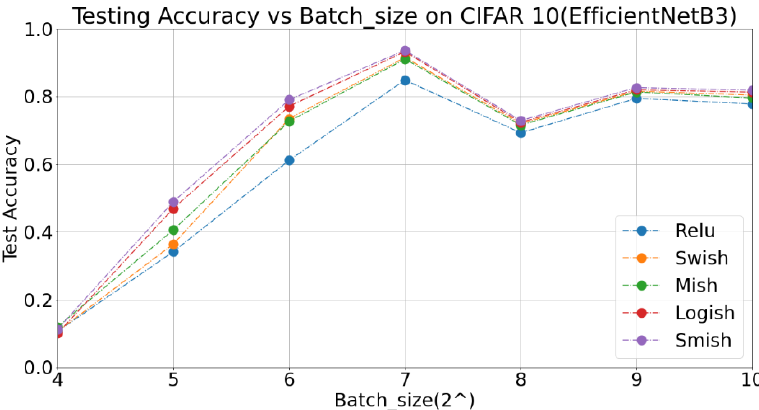
Figure 4. Training accuracy vs. batch_size on CIFAR10.